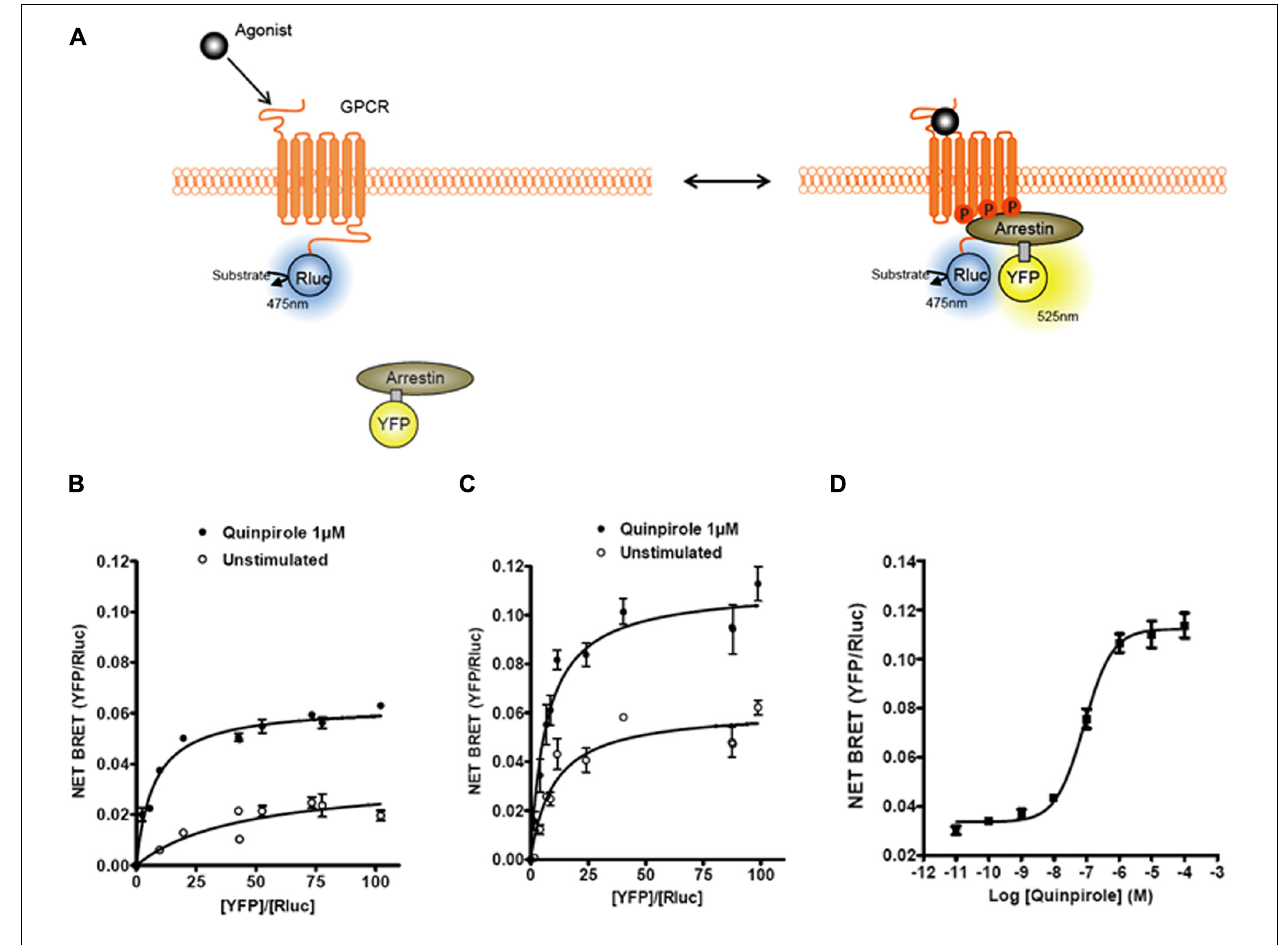
GPCRs are tagged with Rluc to monitor intermolecular interaction by BRET. (B) Titration curves of β -arrestin1–YFP recruitment to D2R–Rluc with or without D2R agonist quinpirole. (C) Titration curves on β -arrestin2–YFP recruitment to D2R–Rluc with or without D2R agonist quinpirole. (D) Dose–response curve of quinpirole effect on β -arrestin2 recruitment to